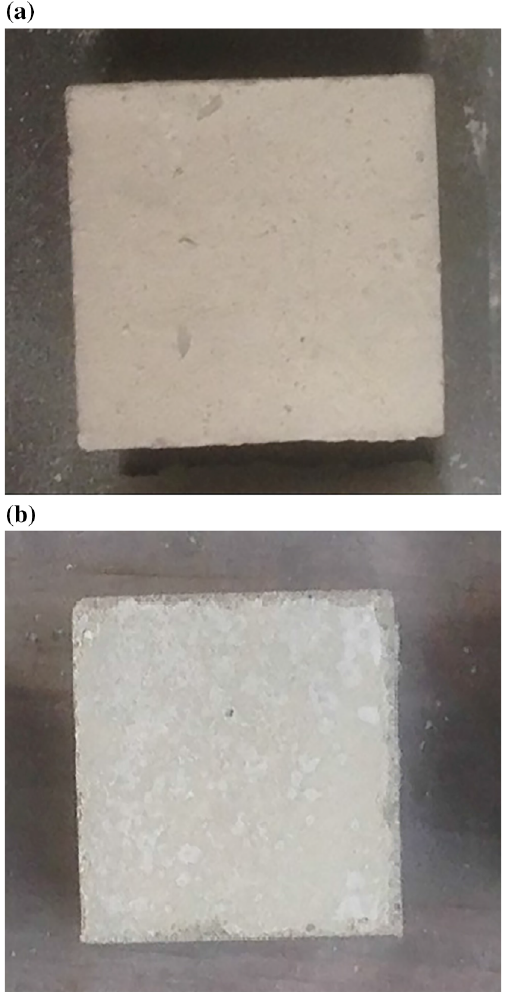
Fig. 8 Relative strength loss after wet–dry cycles for different FNS